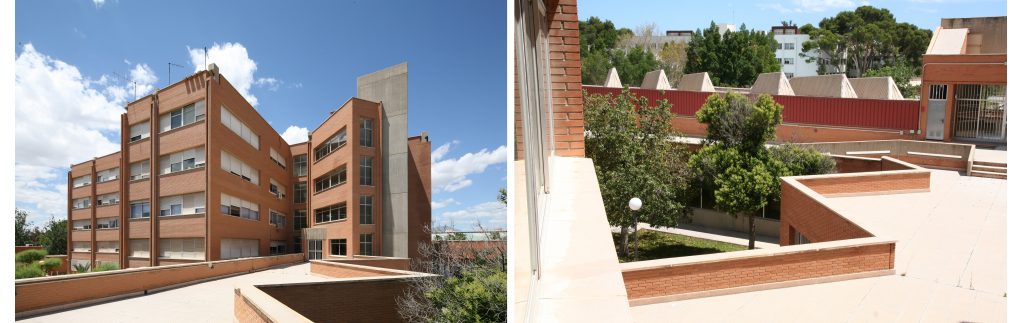
Figure 9. FS: Walkway terraces ( a ) and ( b ). Photo: Courtesy of UA’s Technical O ffi